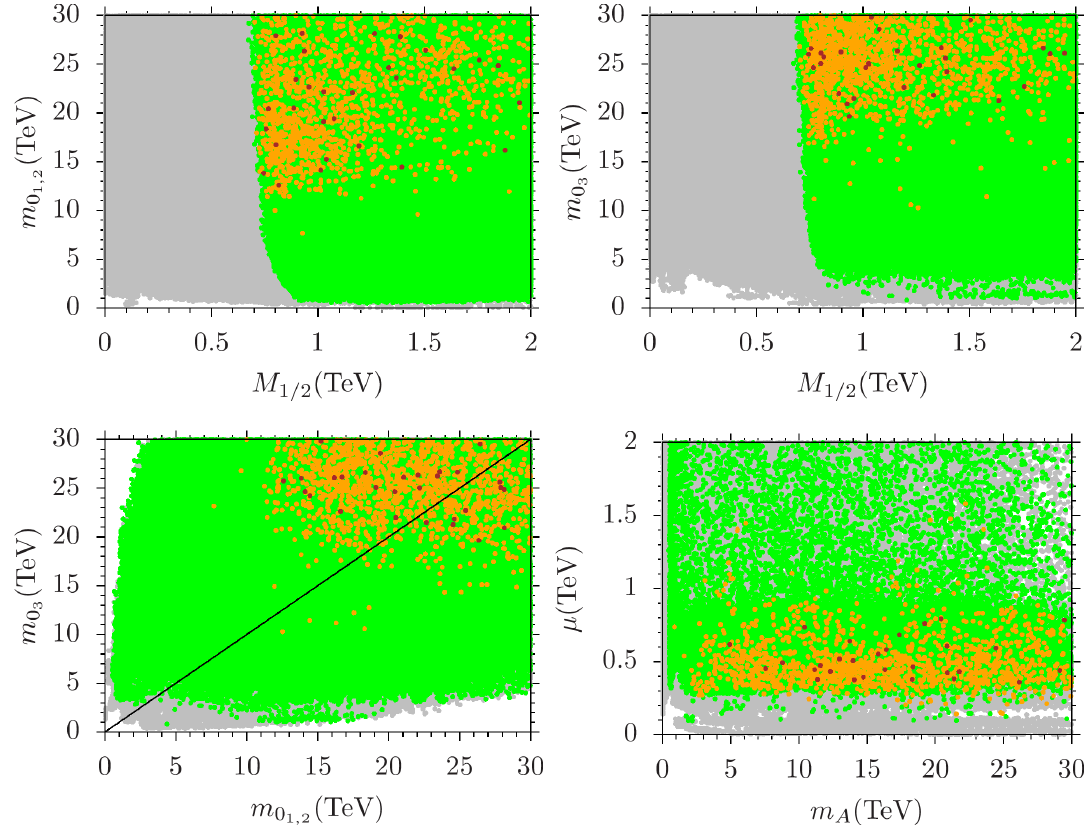
Figure 5 . Allowed parameter space in the m 0 plane. All points are compatible with the REWSB and neutralino LSP conditions. Green points represent the solution which are consistent with the mass bounds on sparticles and Higgs boson, and constraints from rare B -meson decays. The regions consistent with the current proton lifetime are shown in orange as a subspace of green. The bounds from the WMAP measurements are applied on top of the proton lifetime constraint, and the consistent solutions are shown in